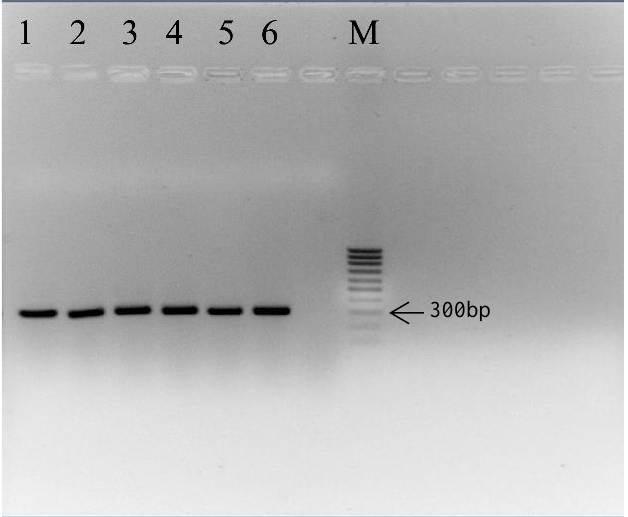
Figure 2. Agarose gel electrophoresis of the ITS1 region of: P. vera L., line 1 (Pver5) and line 2 (Pver7); P. terebinthus L., line 3 (Pter44) and line 4 (Pter45); and P. atlantica Desf. subsp atlantica, line 5 (PatlB4) and line 6 (PatlB7); M: Marker 100 bp ladder.